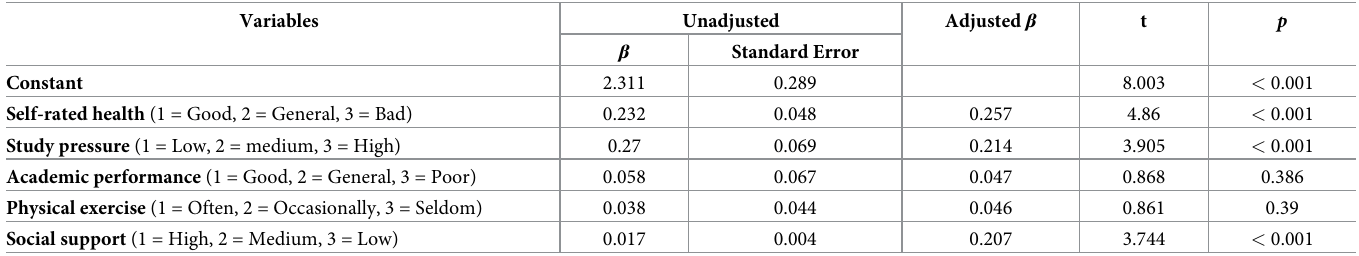
Table 3. Factors associated with the SCL-90 total score: Results of linear regression